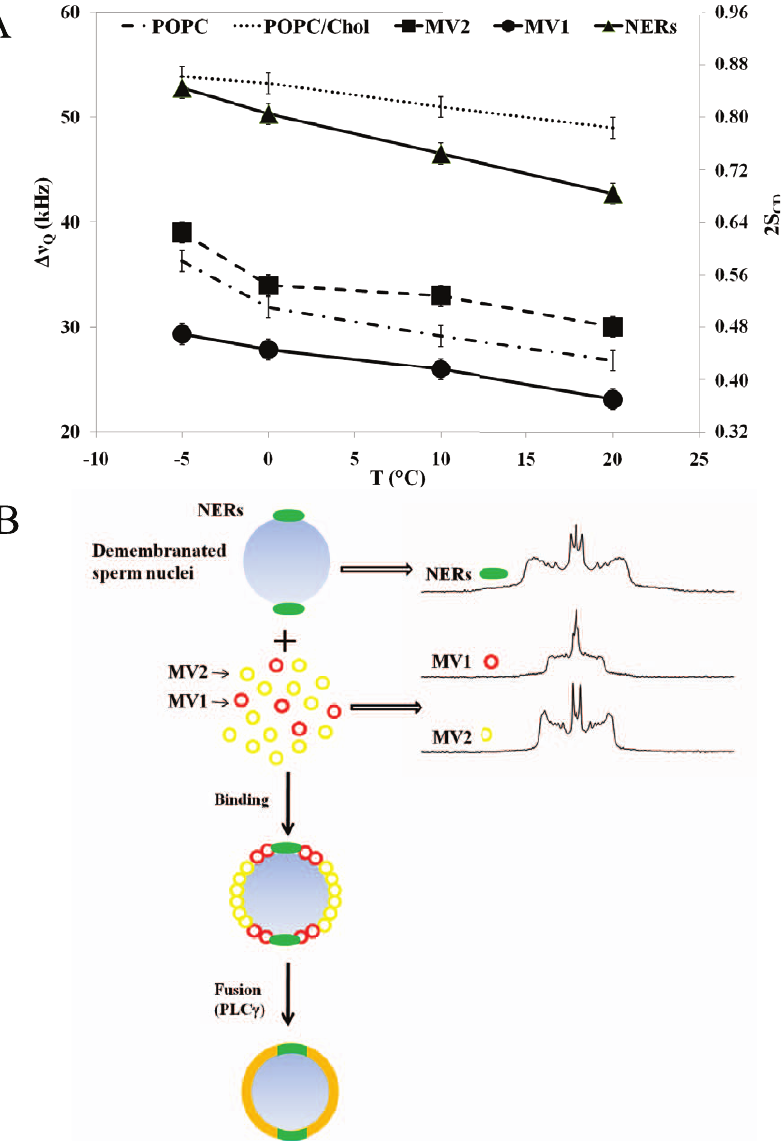
Figure 4. A- Distinct ordering of chain segments close to the glycerol backbone in MV1, MV2 and NERs like membranes. Thermal variation of the plateau (k=2 to 8–10) quadrupolar splittings of MV1 MV2 and NERs model membranes. Data for POPC and POPC/Chol is also shown for comparison. Accuracy of the measure is 6 1 kHz. On the double Y-axis the corresponding Carbon-Deuterium order parameter is shown. Because the average orientation of all plateau C–D bonds is at 90 u with respect to the long lipid axis, twice |S CD | is plotted to express residual ordering information relative to the bilayer normal. FIG. 4B. Scheme describing how the physical properties of NER, MV1 and MV2 membranes could affect nuclear envelope assembly. Left: NERs (relatively-rigid) are located at the poles of the sperm nucleus and play the role of anchorage to chromatin. ‘‘MV1- like’’ membranes are very fluid and hence may have the role to ‘‘prime’’ the process of fusion. PLC c in a second step hydrolyses PtdInsP 2 into DAG, which initiates fusion of vesicles. Right: experimental deuterium NMR spectra of MV1, MV2 and NERs: the wider the trace the more rigid the system.